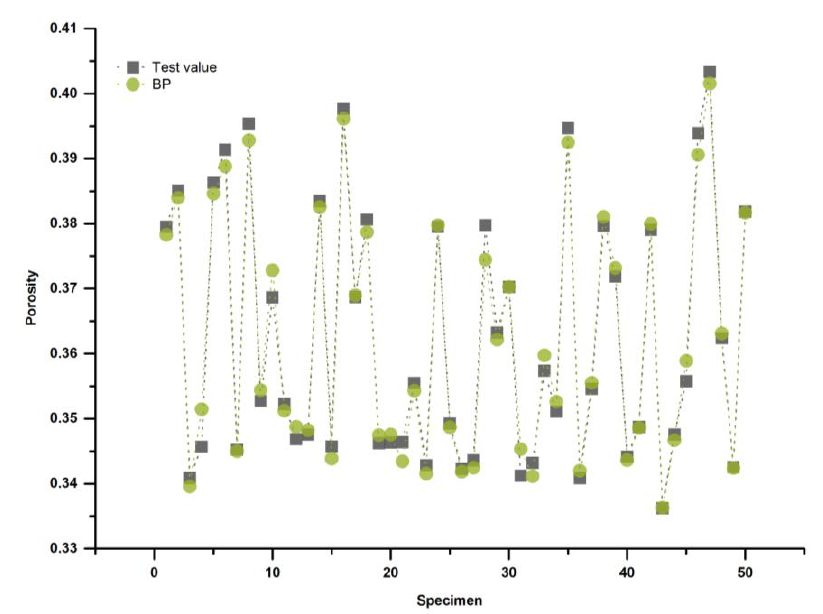
Figure 7. Porosity comparison among testing value and predicted value for Gradation-13.